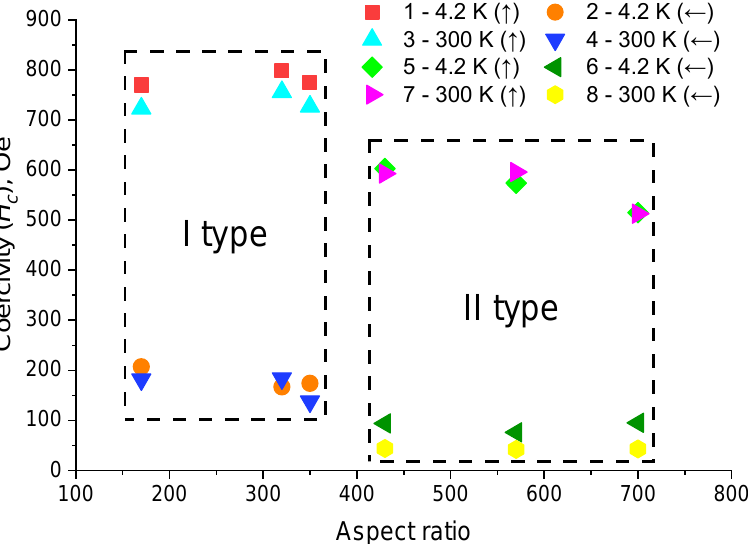
Figure 7. The dependence of the coercivity on the aspect ratio for two types of samples at 4.2 K and 300 K temperatures: 1, 2, 3, 4—the I type (Samples No. 1, 2, 3); 5, 6, 7, 8—the II type (Samples No. 4, 5, 6).